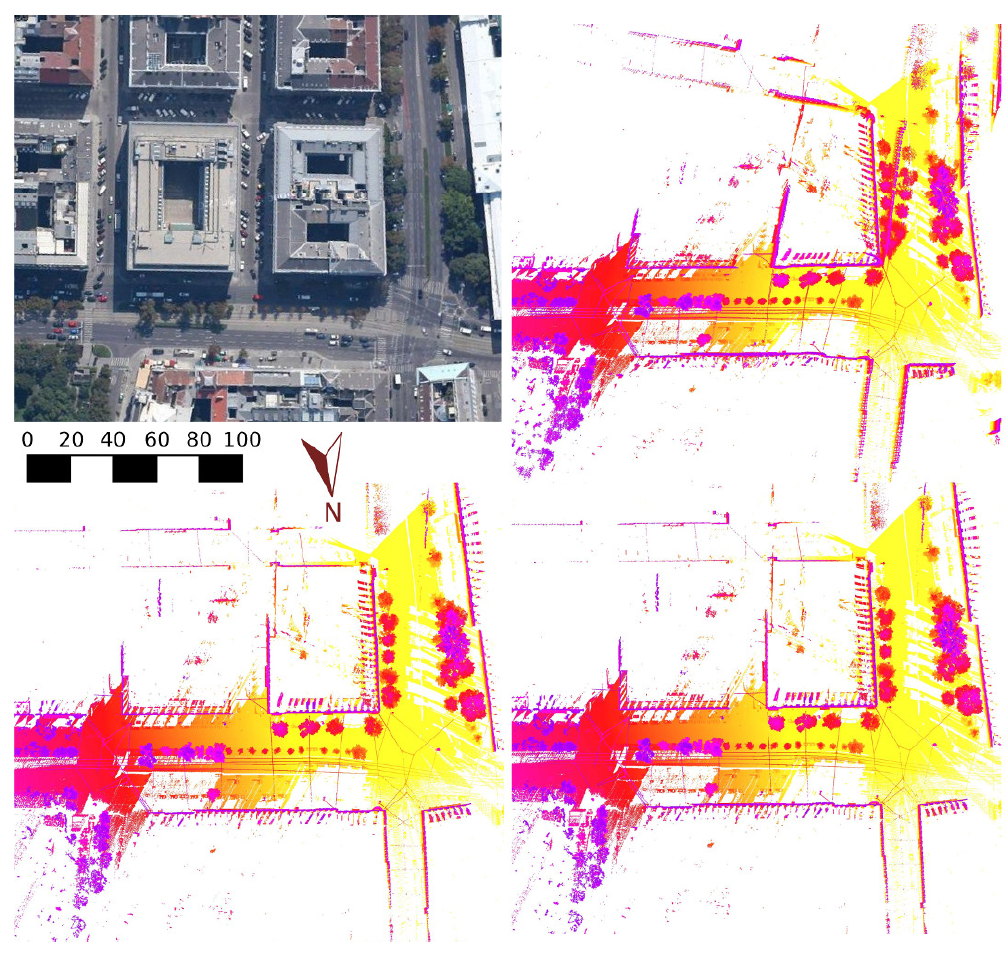
10.3 mm to 8.3 mm. Figure 7. Top view on intentionally perturbed Vienna dataset ( Top Right ), calibrated using the proposed algorithm ( Bottom Left ) and the original, as calibrated by RIEGLLaser Measurement Systems ( Bottom Right ) dataset. An aerial view of the region is shown in the top left. Image courtesy of DigitalGlobe, European Space Imaging and